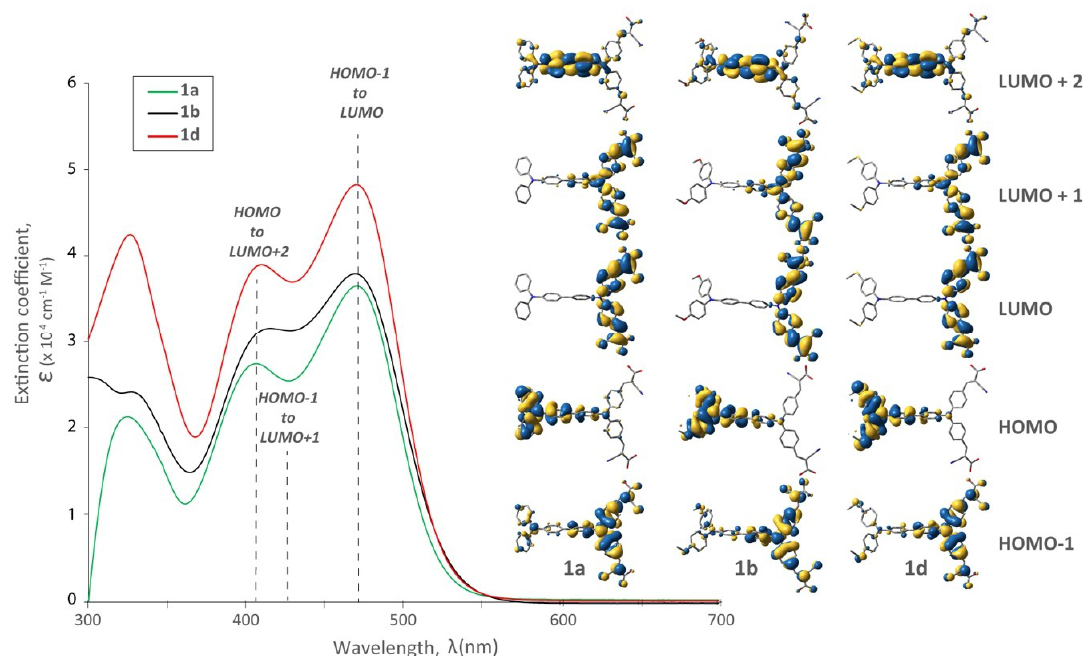
Figure 3. UV-Vis spectra and relevant molecular orbitals of bichromic/bipodal dyes ( 1a , 1b , 1d ) with varied R substituents on the distal TPA while holding the remainder of the structure at parity. Molecules 2020 , 25 , x